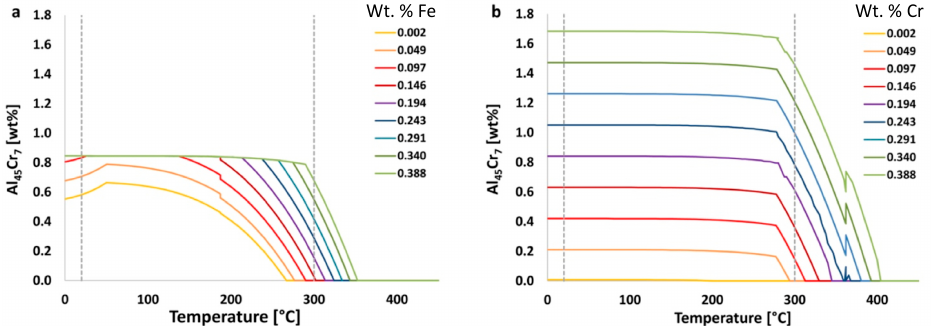
Figure 5. Example used to demonstrate the input for calculating ψ s. ( a ) The variation of the calculated equilibrium Al 45 Cr 7 phase in Al 6061 with iron variability. ( b ) The variation of the calculated equilibrium Al 45 Cr 7 phase in Al 6061 with a content variation of chromium. The temperature of 20 ◦ C is represented by the left-most dashed vertical line. The temperature of 300 ◦ C is represented by the right-most vertically dashed line imposed upon the